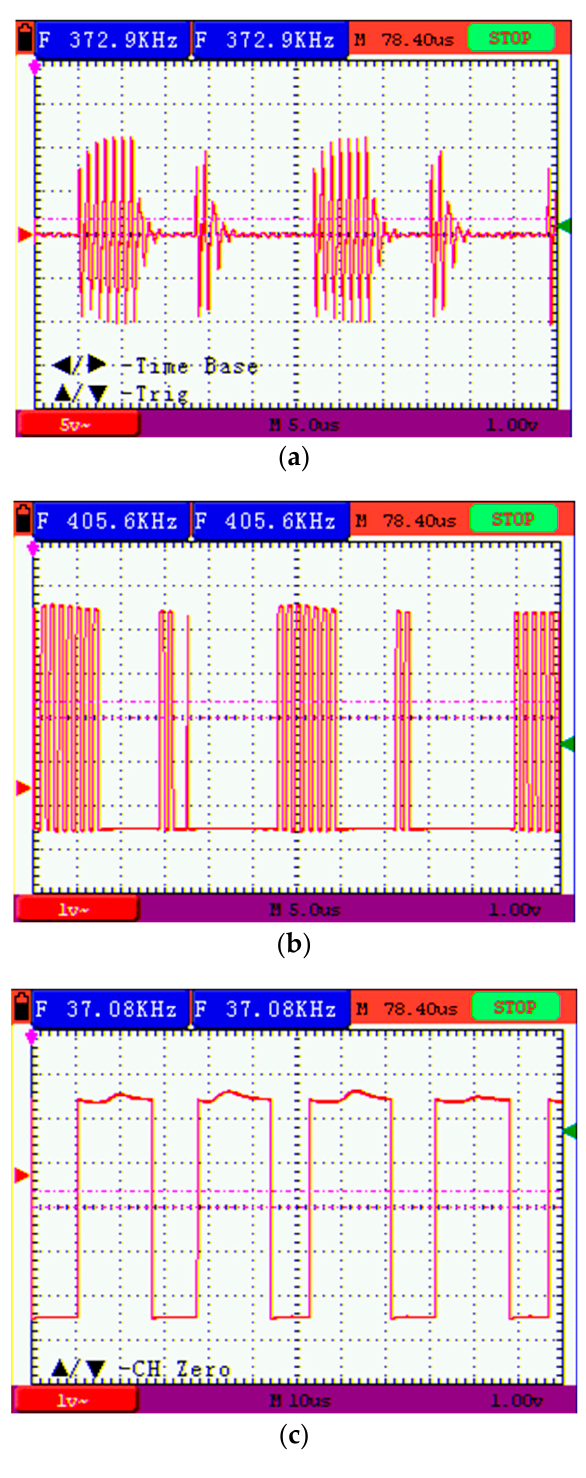
Figure 3. ( a ) Analog form of the modulated signal at one receiver input; ( b ) digital output of the RX comparator for the same received signal; ( c ) digital frame received (alternating 1,s and 0,s).